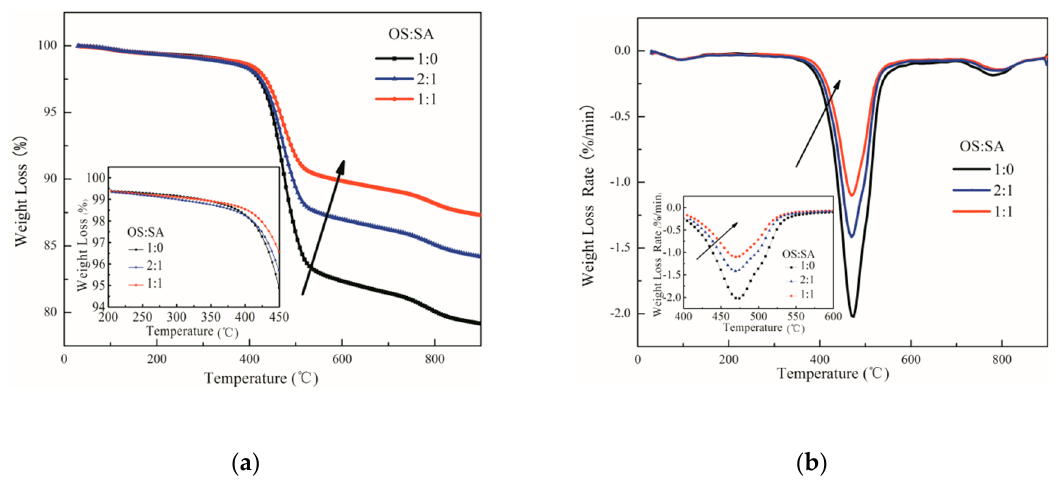
Figure 1. ( a ) TG (Thermal Gravity) and ( b ) DTG (Differential Thermal Gravity) curves for different mass ratios of OS:SA.